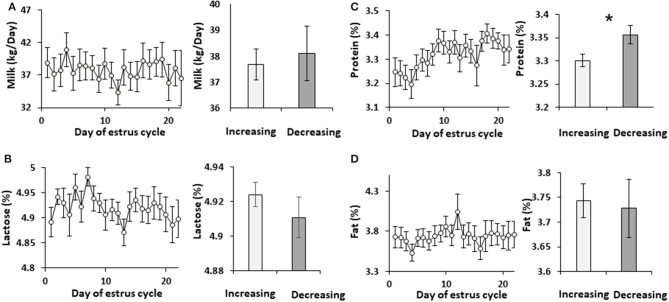
Milk yield and solids concentration through the estrous cycle. The daily values of milk yield and solids concentrations, and the mean values during the increasing and decreasing progesterone concentration phase throughout the estrous cycle are presented: (A) milk yield (L/day); (B) concentration in milk of lactose (%); (C) concentration of protein (%); (D) concentration of fat (%). No differences were found throughout the estrous cycle in milk yield (p = 0.97) or in the concentration of lactose, protein, and fat (p =0.79, 0.21, and 0.98, respectively). No differences were observed when the mean values of milk yield and the concentrations of lactose and fat between the increasing and decreasing phase of progesterone concentrations were compared (p = 0.71, 0.3, 0.8, respectively). However, protein concentration was lower in the increasing phase of progesterone concentration of the estrous cycle compared with the decreasing phase (p =0.019). *indicates significant difference, P < 0.05.